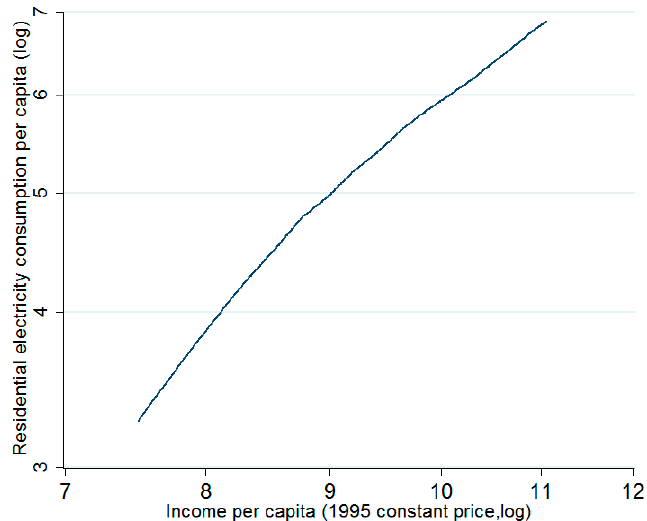
Figure 4. Estimated income effect on residential electricity consumption. Note: The income range has been divided into 10 segments by percentile so each segment contains the same number of observations. The residential electricity consumption per capita on the vertical axis has been adjusted for the effect of income excluding the province ‐ fixed effect.